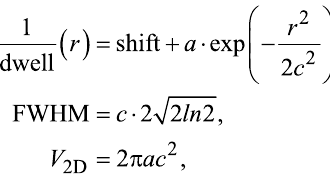
Data for two instrument apertures corresponding to two differ- ent beam currents are presented: squares for 1.5 pA and circles for 18 pA beam current. STEM dark field (DF) images of a pore array created with 18 pA beam current are shown in the inset of Figure 1d. The pore diameter vs ion exposure dose curves have very distinct shape Figure 1d. Pore diameters steeply increase for the low exposure doses and then gradually increase for larger doses. For 1.5 pA Ga-FIB current and 0.5 ms dwell time pores with diameters as small as 5 nm could be reliably created and identified. Dwell times of 0.3 ms resulted in a large